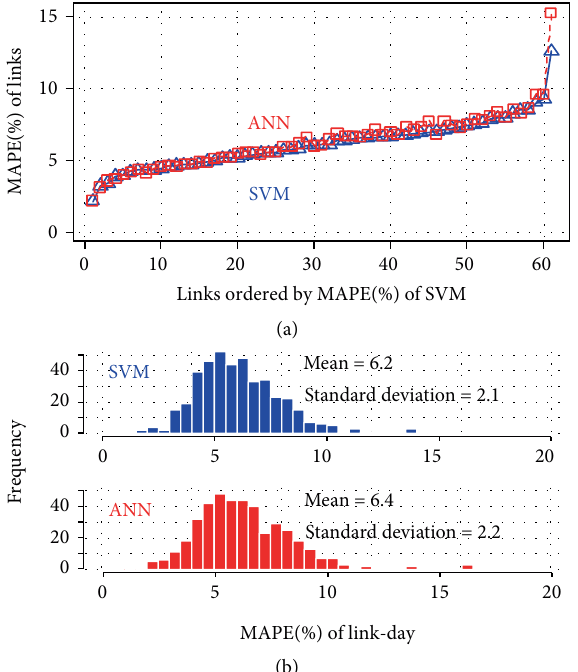
Figure 4: Comparision of prediction performance of benchmark models, ANN and SVM: (a) MAPE(%) of link unit and (b) MAPE(%) of link-day